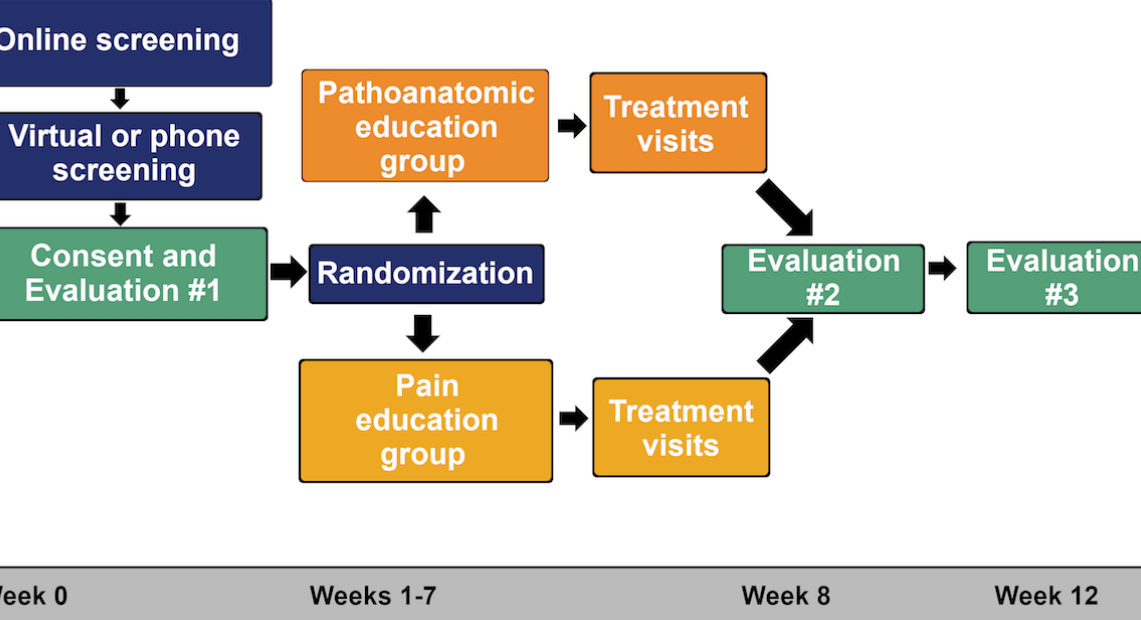
Figure 1. After consent and baseline measures at Evaluation #1, participants who satisfy all eligibility criteria are randomized to education group. A physical therapist provides education along with exercise over 6-7 individual treatment sessions. At 8-weeks participants complete Evaluation #2 to repeat all baseline measures. At 12-weeks the participants complete Evaluation #3, which consists of online